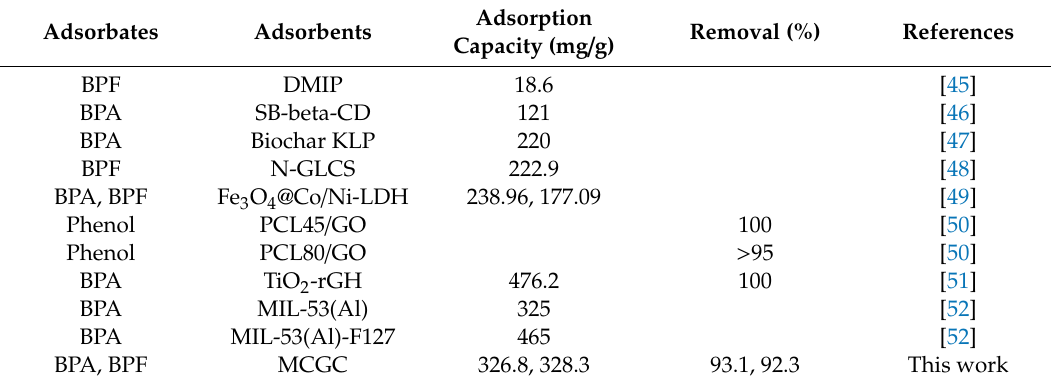
Table 4. Comparison of the adsorption capacities of various adsorbents for BPA and BPF